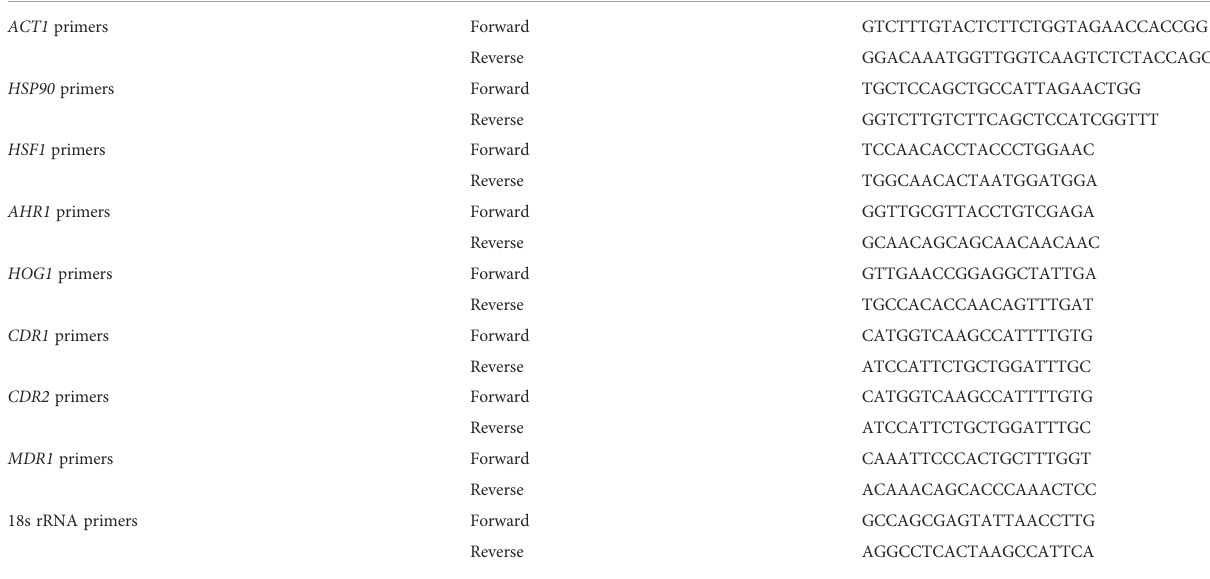
TABLE 4 Oligonucleotide primers used for qRT-PCR in this